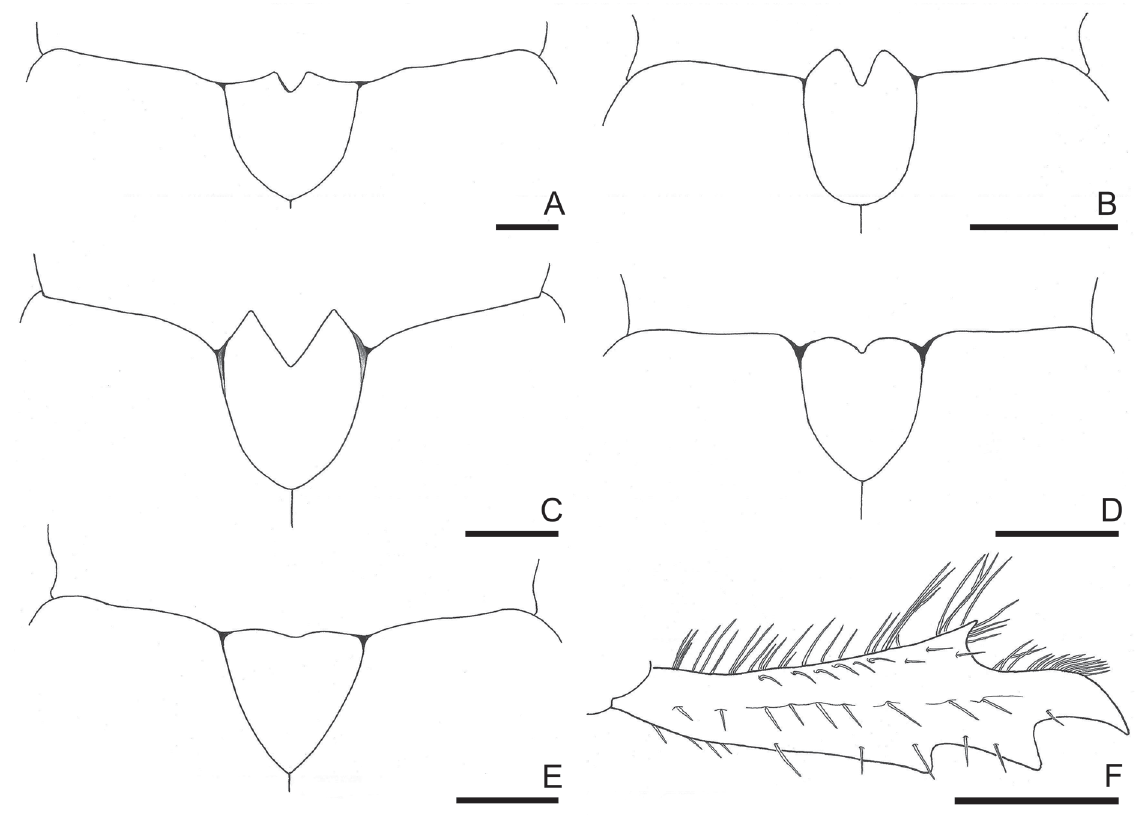
Fig. 8. A−E . Pronotum−scutellum contact. F . Protibia. A . Ancistrosoma klugii Curtis, 1835. B . Chariodema virescens Blanchard, 1842. C . Ceraspis bivulnerata (Germar, 1824). D . Faula cornuta Blanchard, 1850. E−F . Manopus biguttata Conte de Castelnau, 1840. Scale bars =